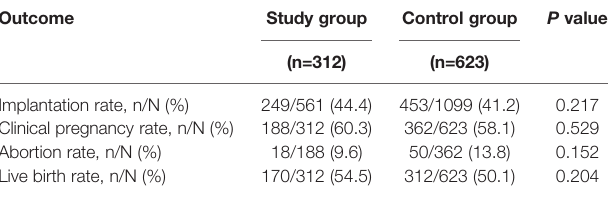
TABLE 3 | Clinical outcomes after propensity score